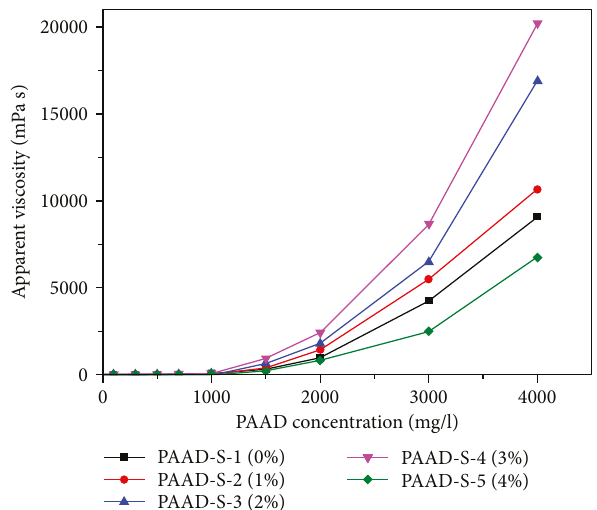
Figure 6: Variation of the surface tension with concentration of PAAD in water with the NaCl concentration of 1000 mg/l at 25 ° C.